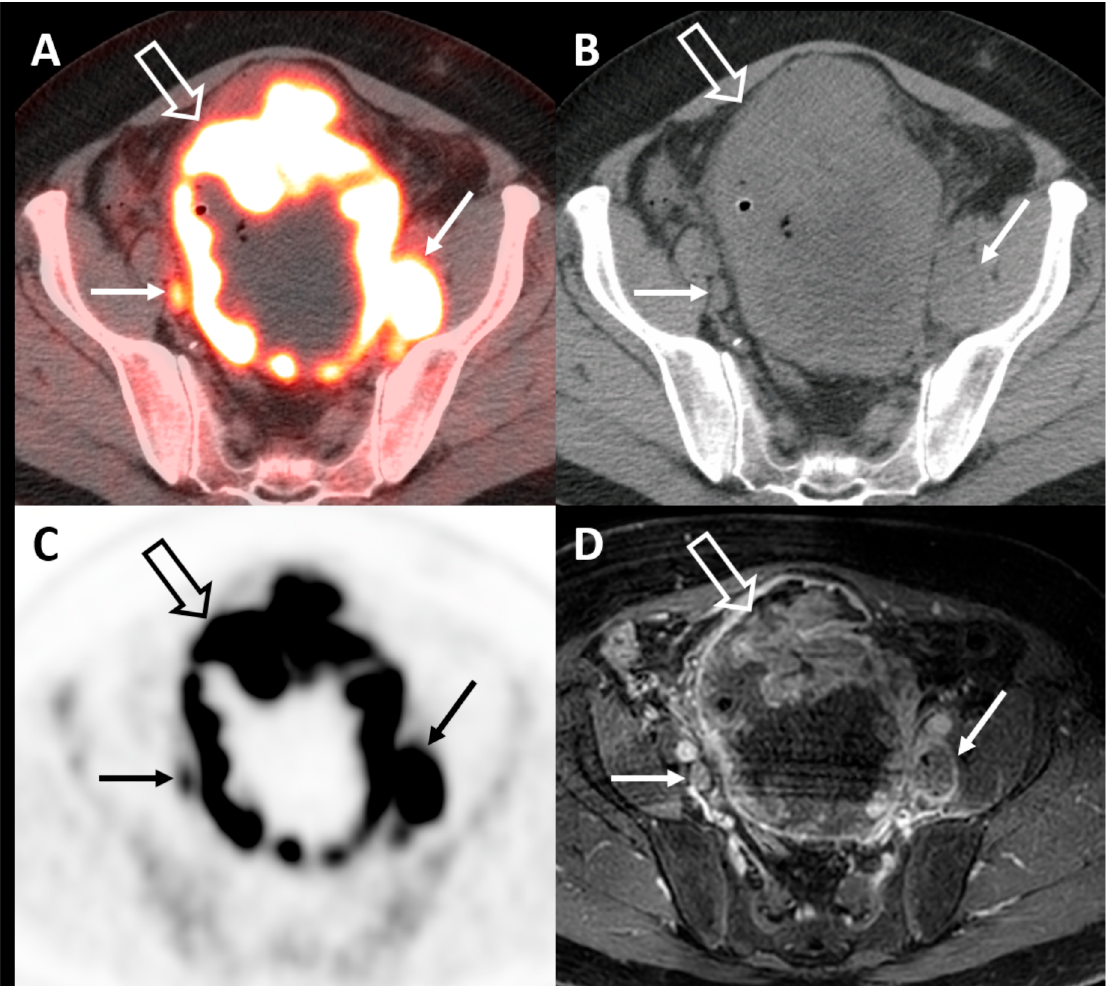
Figure 3. Axial fused FDG-PET/CT ( A ), CT ( B ), PET ( C ), and corresponding T1-fat saturated postcontrast MRI ( D ) demonstrating an extensive hypermetabolic mass involving nearly all of the bladder wall (open arrow) and multiple pelvic lymph node metastases (closed arrow), some of which measure less than 1 cm in short axis and are more easily identified on PET/CT vs. CT or MRI alone.